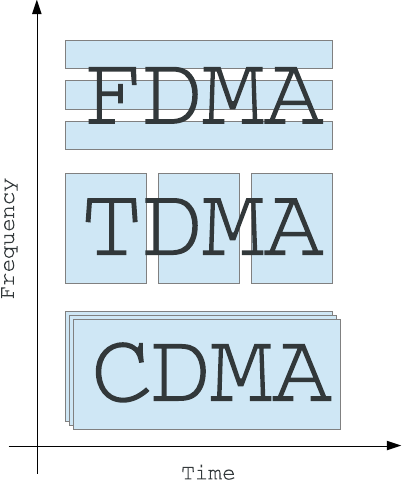
Figure 4. Contention-free communication can be accomplished by assigning time, frequency or unique